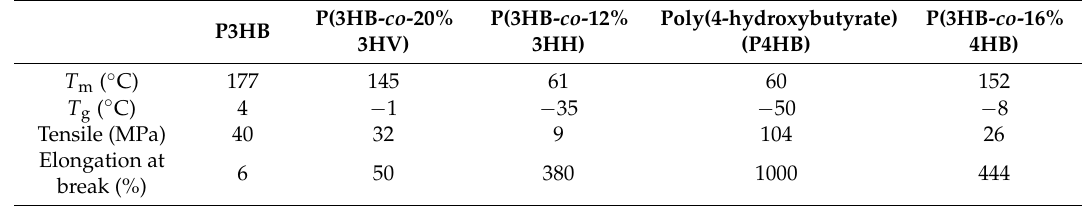
Table 5. Thermal and mechanical properties of representative PHAs [45].